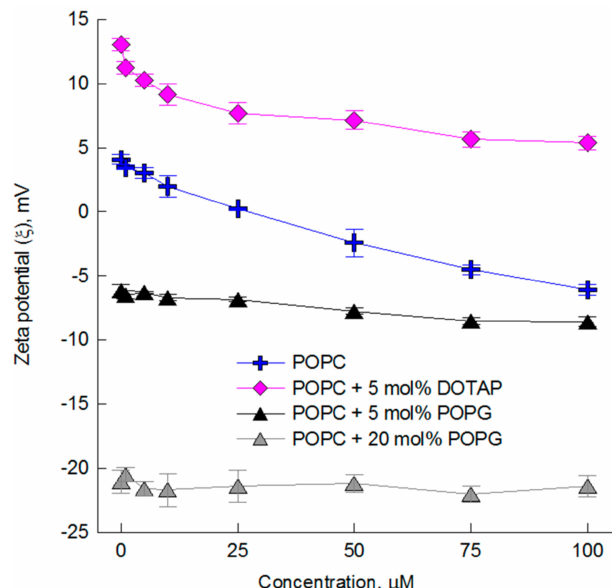
Figure 4. The Zeta potential values of LUVs liposomes formed from zwitteronic lipids (POPC) and with positive (POPC-DOTAP) and negative (POPC-POPG) charge net. The measurements were done 15 min after modification of liposomes by cyanidin used at different concentrations (10–100 µ M). The experiment was repeated thrice and the results are shown as mean value ± standard